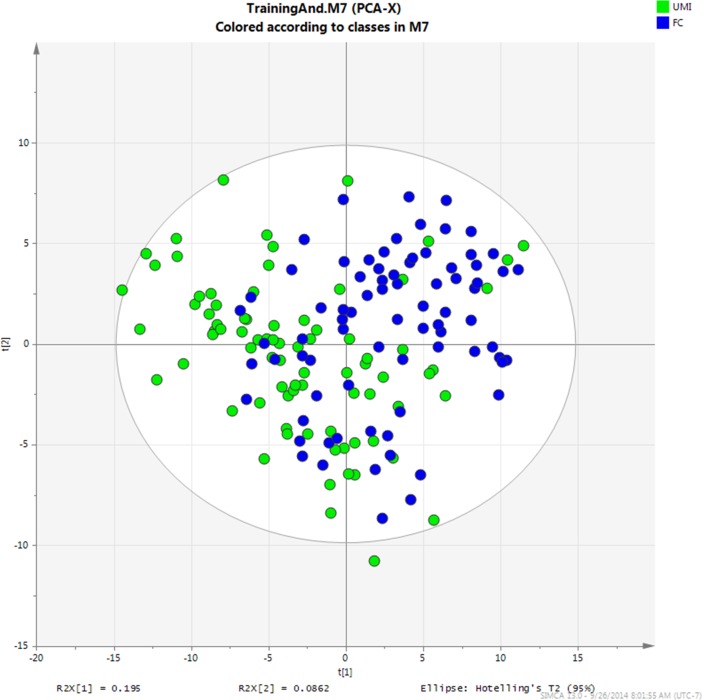
PCA score plot for training set.